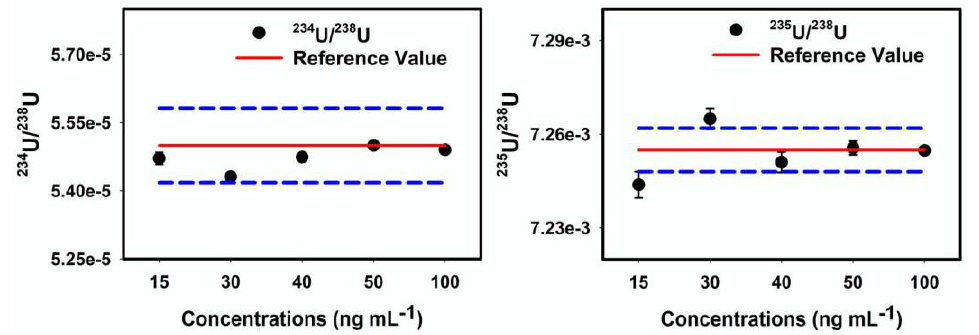
Figure 4. 234 U/ 238 U and 235 U/ 238 U isotope ratio measured on different concentrations of uranium in ‘in-house standard’. The blue dotted line indicated twice the standard deviation (2SD) of the measurement.